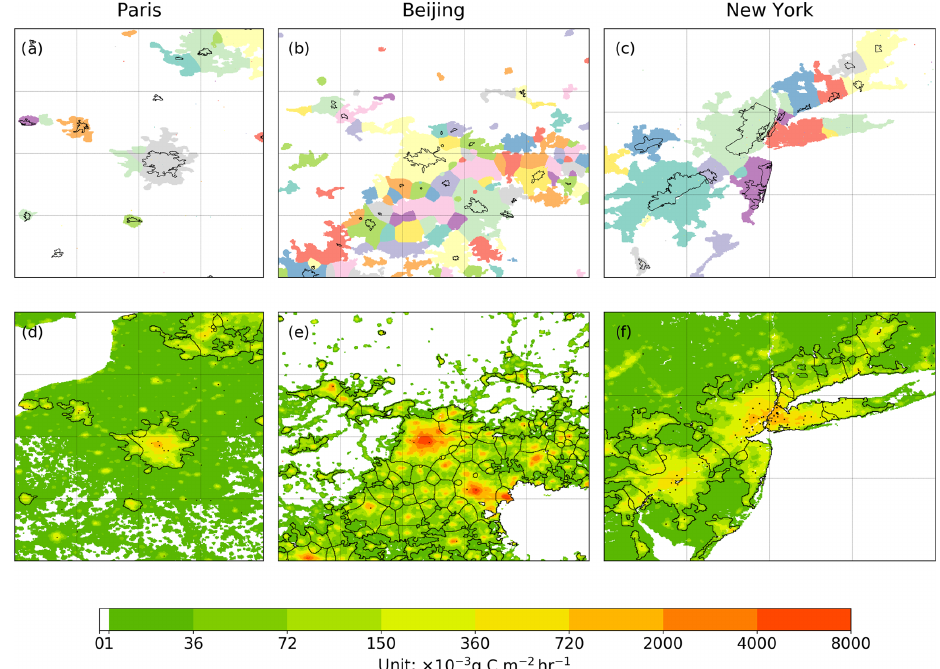
Figure 4. Emission clumps near Paris (a, d) , Beijing (b, e) and New York (c, f) . In panels (a) – (c) , solid lines depict the urban areas from ESRI product. Colored patches depict the clump area resulting from the algorithm defined in this study. In panels (d) – (f) , solid lines depict the boundaries of final clumps (boundary of colored patches in panels a – c ). Colored fields in panels (d) – (f) show the emissions from the ODIAC product. Light dashed lines indicate 1 ◦ × 1 ◦